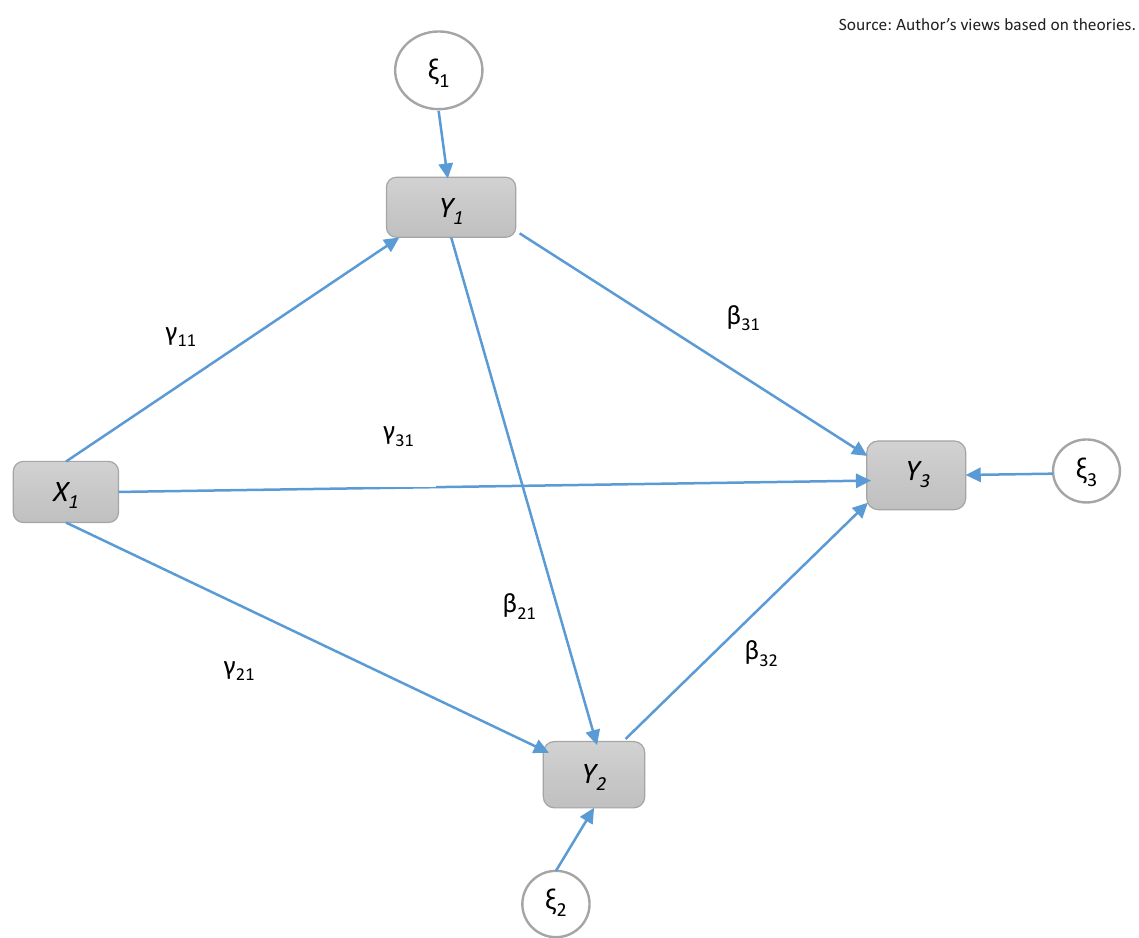
Figure 1. Possible recursive path model for